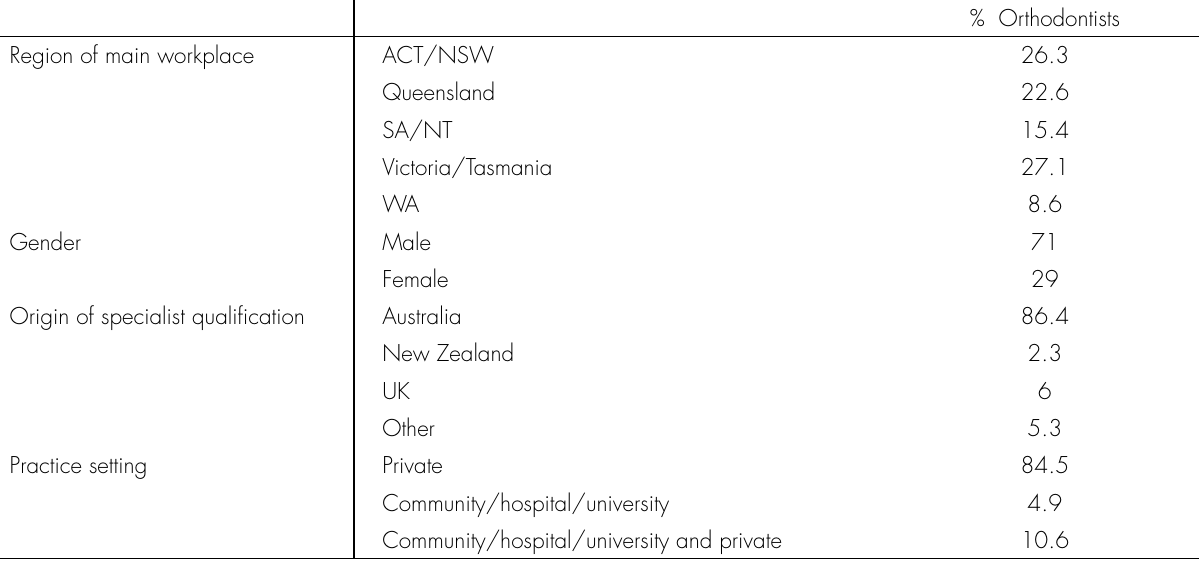
Table II. Most commonly used retainer in the maxilla and mandible following comprehensive orthodontic treatment by orthodontists.